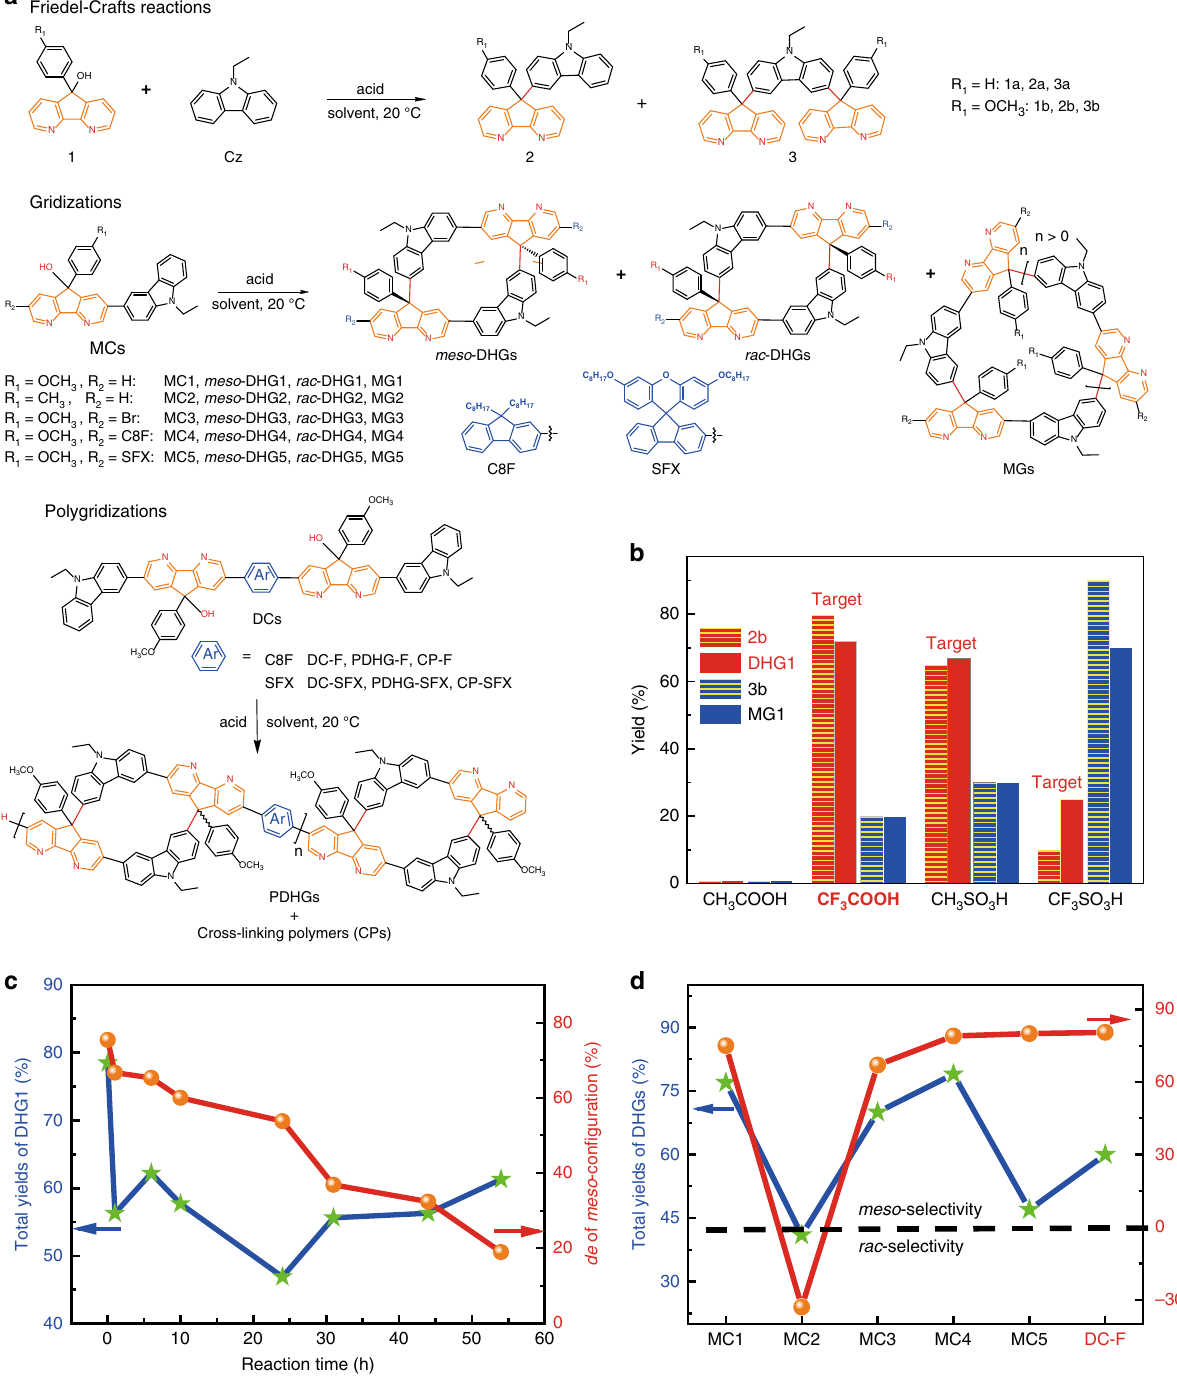
Fig. 2 Characteristics of the Friedel – Crafts reactions, gridizations, and polygridizations. a Corresponding formula. The R 1 and R 2 groups are depicted in red and blue, respectively. b The dependence of acid additives on the yields (after 30 s of reactions). The volume ratio of the acid additive to dichloromethane (DCM) is about 1/3. The concentration of substrates is about 10 ∼ 15 mM. For the Friedel – Crafts reactions, the height of red and yellow column corresponds to the yield of 2b ; the height of blue and yellow column represents the yield of 3b . For the gridization reactions, the heights of the pure red column and the pure blue column correspond to the yields of DHG1 and MG1, respectively. c The dependence of gridization times on the meso - selectivity of MC1, under the conditions of DCM solvent, CF 3 COOH acid additive, and CF 3 SO 3 H acid catalyst. The blue line and green stars exhibit the total yields of DHG1, and the red line and orange dots show the de value of meso -con fi guration. d The total yields (green dot and blue line) and the meso - selectivity of DHG-based products (orange dot and red line) under the optimized conditions in 1 min. The black dashed line is the boundary between the meso -selectivity and rac -selectivity. The yields of PDHG-F is de fi ned as the sample after fully undergoing Soxhlet